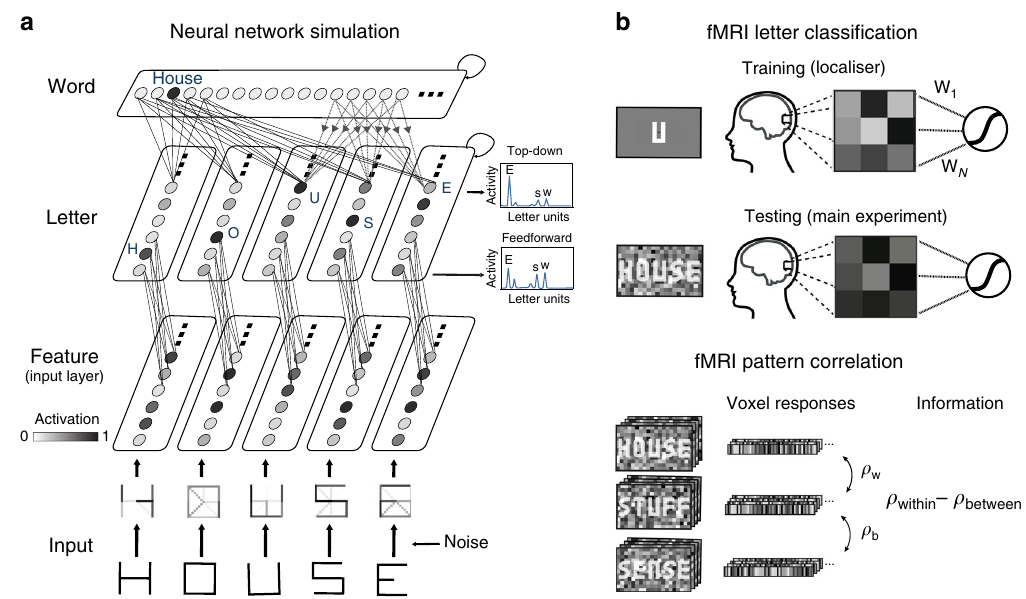
Fig. 2 Probing representational enhancement in neural network models and the brain. a Modelling representational enhancement in a hierarchical neural network model 6,14 . Stimuli used in the experiment were encoded into vectors of visual features and overlaid with Gaussian noise (bottom rows). Inputs were presented to a network with or without word-to-letter feedback connections. For both networks, representational strength was quanti fi ed from the distribution of activity levels of letter units for the third position (principle illustrated for the fi fth letter, E). Solid circles indicate units (representing features, letters or words); lines indicate feedforward connections, and dotted lines with arrows indicate feedback connections. Note that we used a predictive coding formulation of the network 14 but for simplicity only the state estimator (prediction) units are shown in the schematic (see Methods for details). b Quantifying representational letter enhancement using multivariate pattern analysis (MVPA). To probe letter representations in the brain, we used two MVPA techniques: classi fi cation (upper panel) and pattern correlation (lower panel).